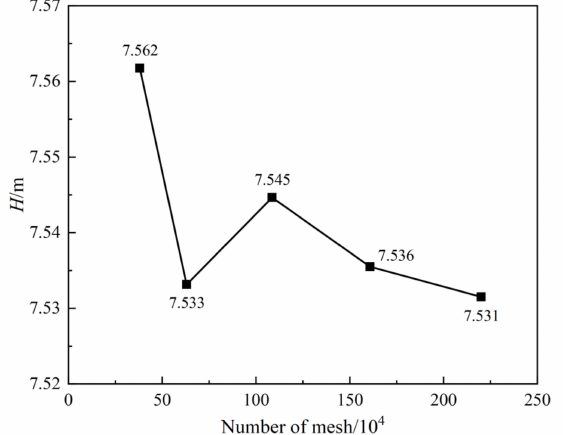
Figure 3. Mesh independence